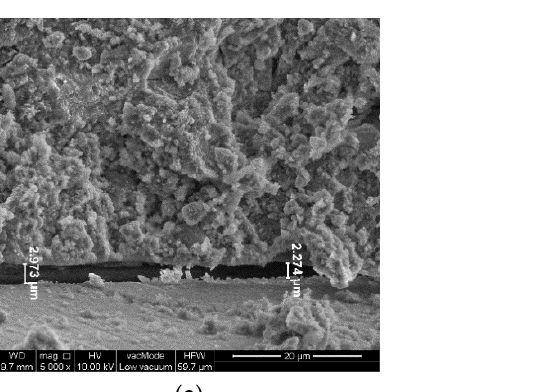
Figure 8. SEM photographs of microstructure of reference concrete composite ( a ) 20 °C, 0% of glass; ( b ) 800 °C, 0% of glass.